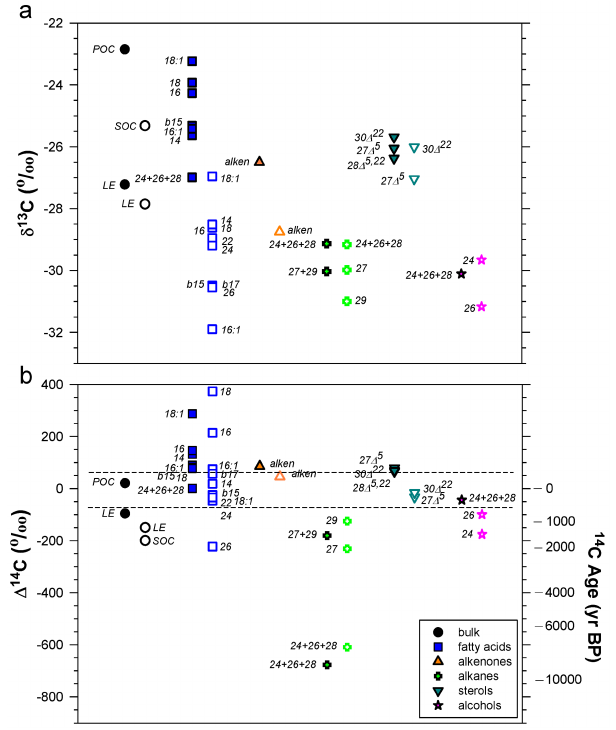
Figure 8. The (a) δ 13 C and (b ) (cid:49) 14 C values of bulk POC and SOC and individual biomarkers for trap and sediments from the Black Sea (see also Table 1). Filled symbols are trap biomarkers; open symbols are sediment biomarkers. All values have been cor- rected for procedural blanks and any derivative carbon, as needed. Dashed lines are pre-bomb (lower) and post-bomb (upper) mixed- layer (cid:49) 14 C DIC